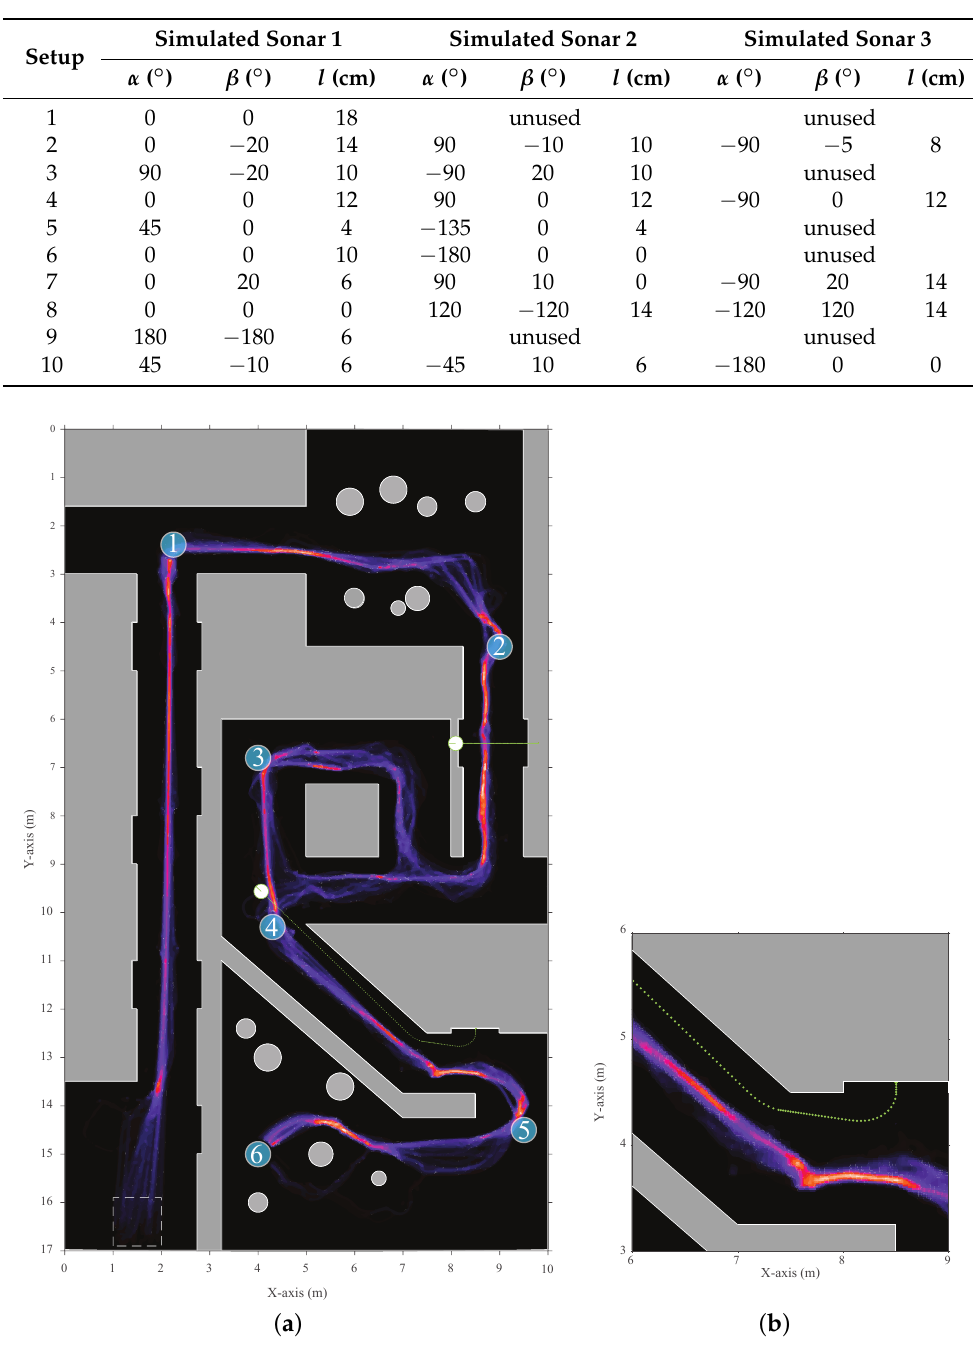
Table 1. Simulation multi-sonar setups.